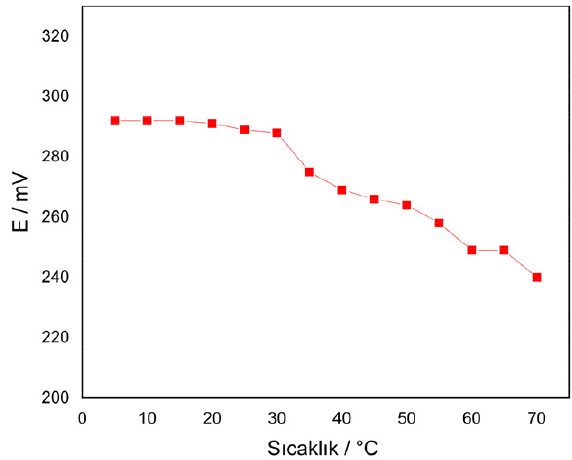
Figure 8. Effect of temperature on the DOP-selective microsensor